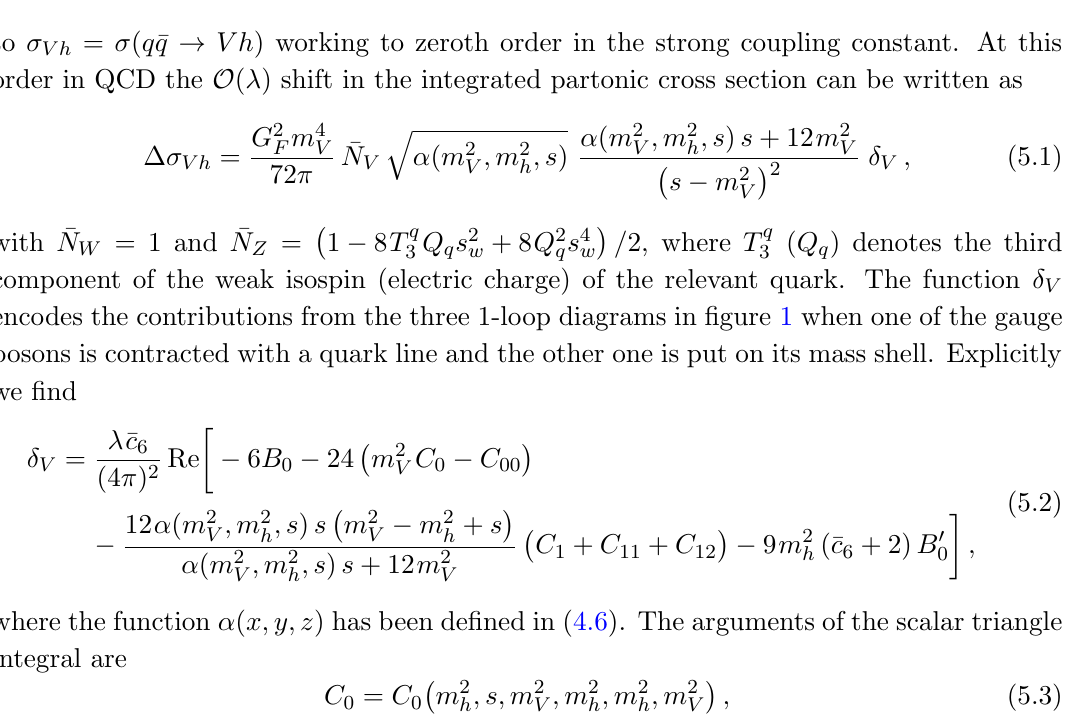
Figure 3 . Examples of diagrams that contribute to pp ! Zh at O ( (cid:11) 2 square the left and middle diagram receive a correction of O ( (cid:21) ) from (cid:14) V , while the graph on the right-hand side does not involve a modi(cid:12)ed ZZh vertex. See text for further